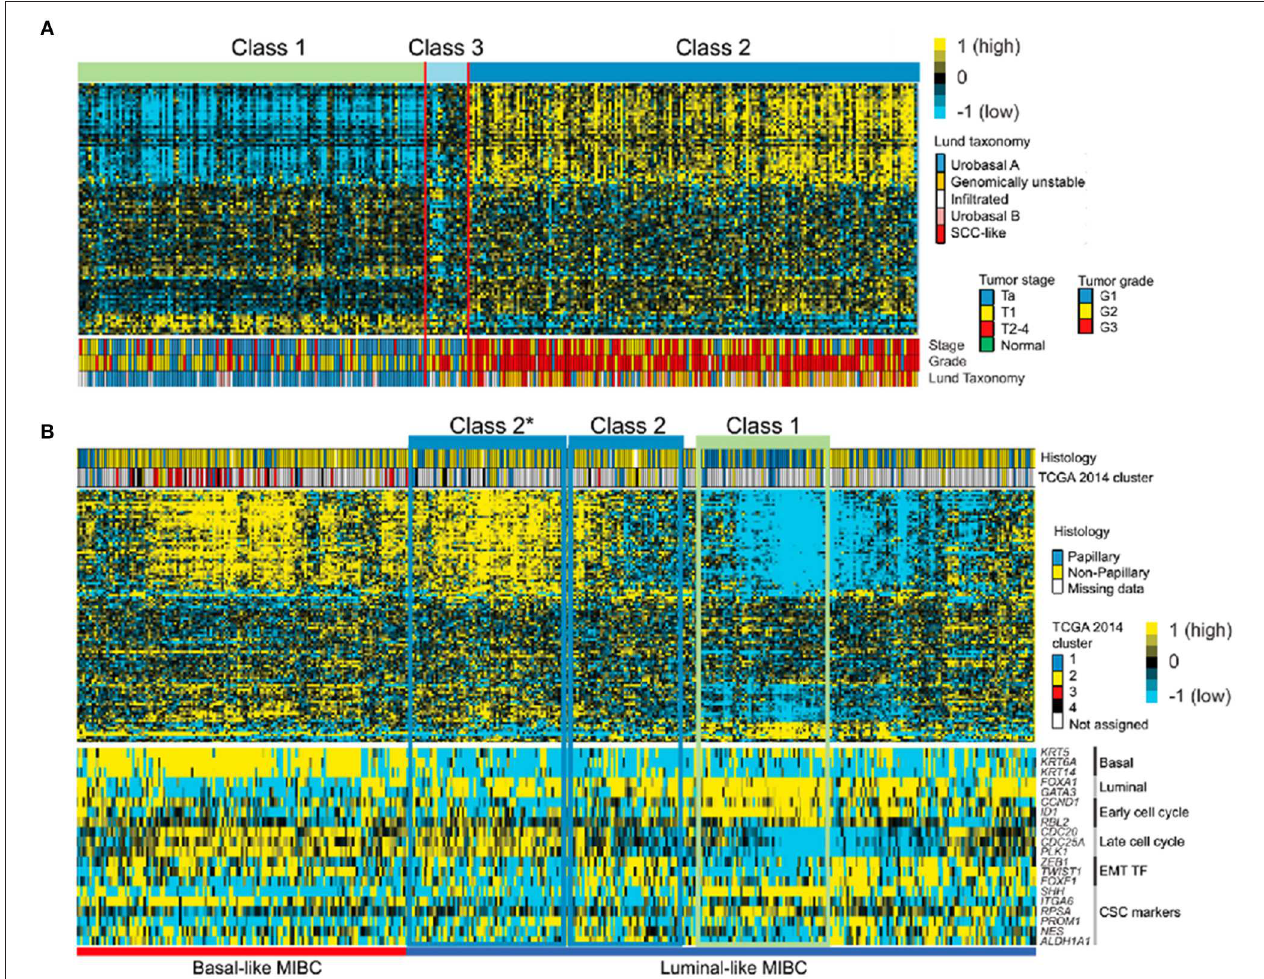
FIGURE 3 | The correlation among UROMOL 2016 and other molecular subtyping systems (33). (A) The UROMOL 2016 subytping system analyzed the microarray data from 306 tumors from the Lund group based on 95 of 117 classifier genes (33). The Class 1 subtype is highly similar to the urobasal A subtype, and Class 1 subtypes mainly consist of low-risk NMIBC, while high-risk NMIBC tends to be concentrated in the Class 3 and Class 2 subtypes. (B) UROMOL 2016 was used to subtype the TCGA database (33). Heatmap of mRNA-seq data from 408 MIBC samples from TCGA based on 107 of the 117 classifier genes. Class 1 and Class 2 tumors are highlighted based on expression profile similarities to original classes. Class 2*: tumors with high similarity to Class 2 but with differences in EMT and CSC marker expression ( 33). Yellow, high expression; blue, low expression. SSC, squamous cell carcinoma; EMT, endothelial-mesenchymal transformation; CSC: cancer stem